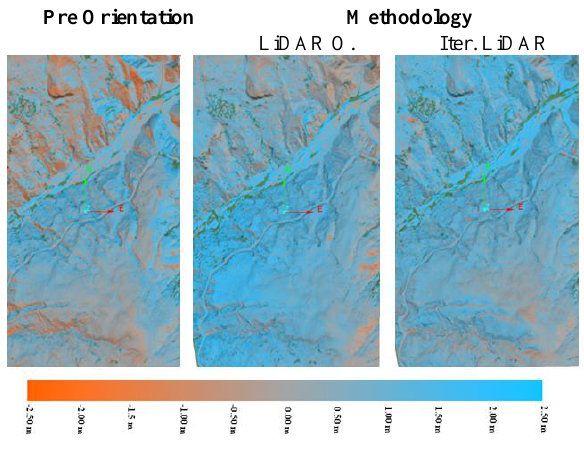
Figure 10: 2001 Orientation Evolution